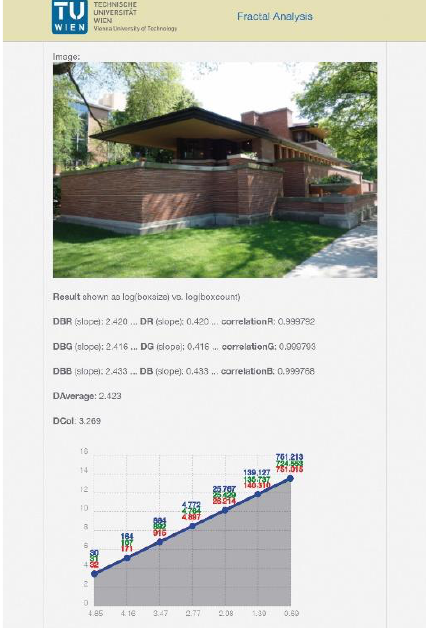
Figure 2. Box-counting with FRACAM.